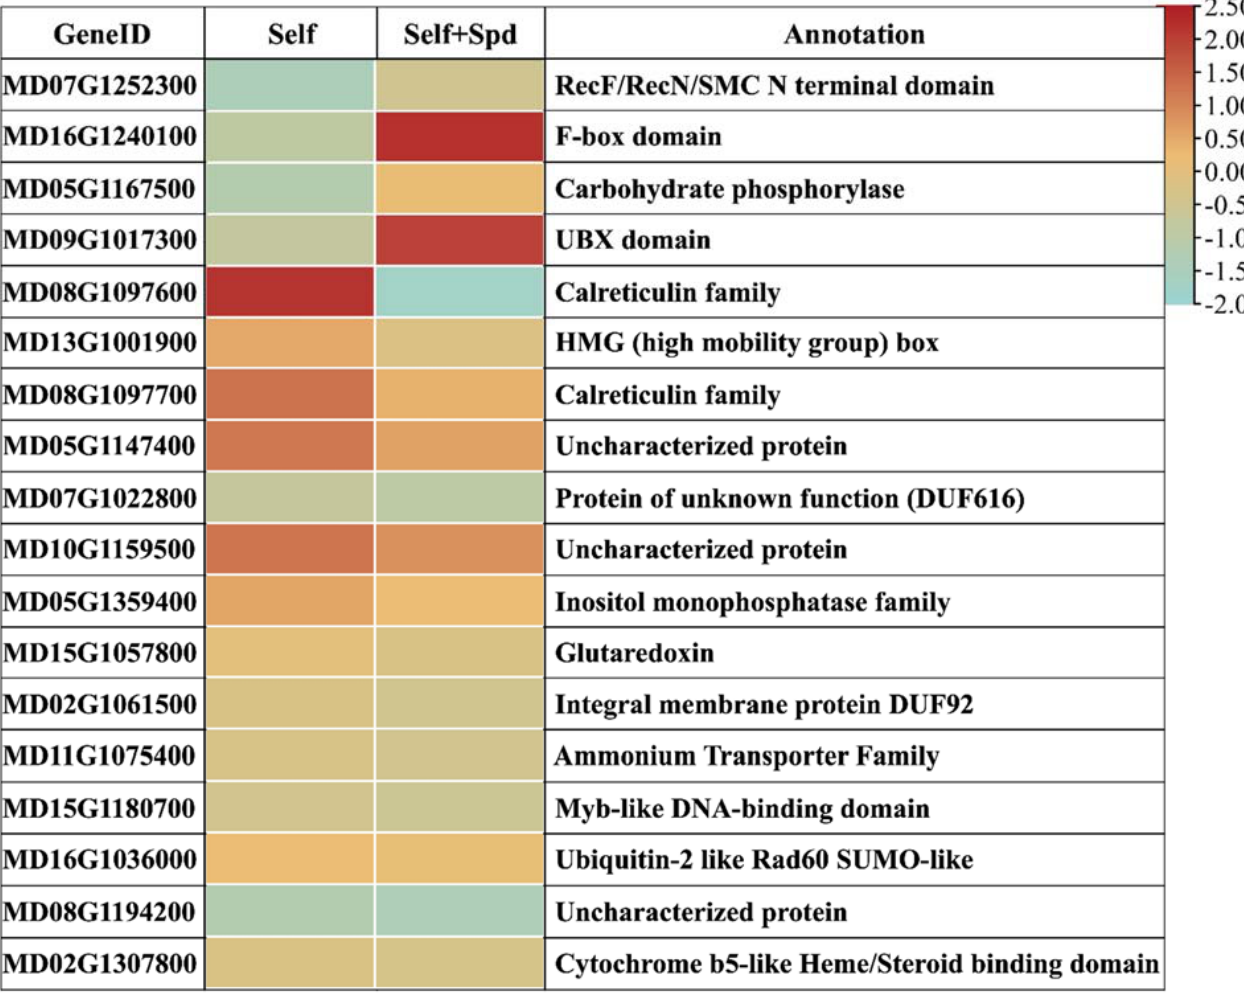
Figure 5. Heat map representing the differentially expressed transcripts between pollen tubes treated with self-S-RNase and pollen tubes treated with self-S-RNase and added 0.25 exogenous spermidine. Values are means of three biological replicates. Heatmap of log transformed FPKM values of differentially expressed transcripts differenced treated.